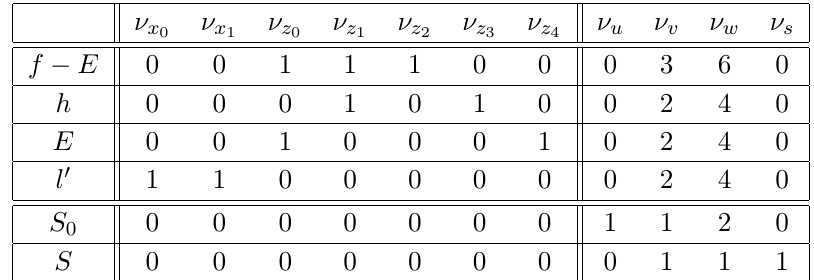
Table 1 . GLSM charges of the toric coordinates of the Bl 1 P 2 The upper-left part, as separated by the horizontal and the vertical double lines corresponds to the description of the base B 3